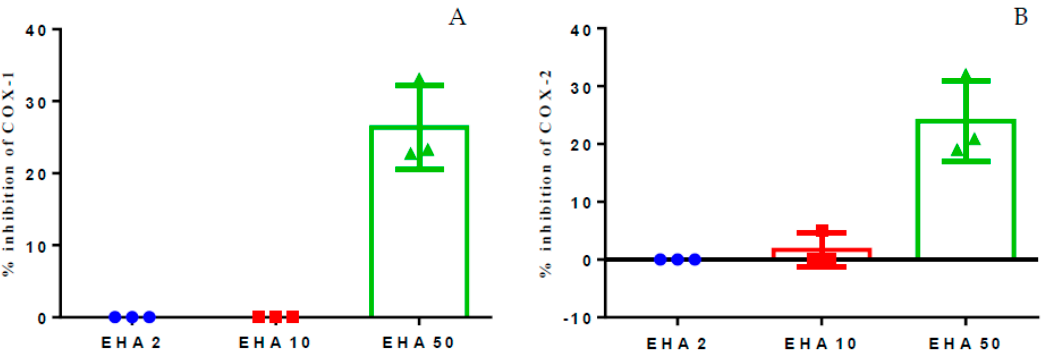
Figure 1. Percent inhibition of in vitro COX-1 ( A ) and COX-2 ( B ), induced by the hydroethanolic extract of A. chica, tested in three concentrations: 2, 10, and 50 μ